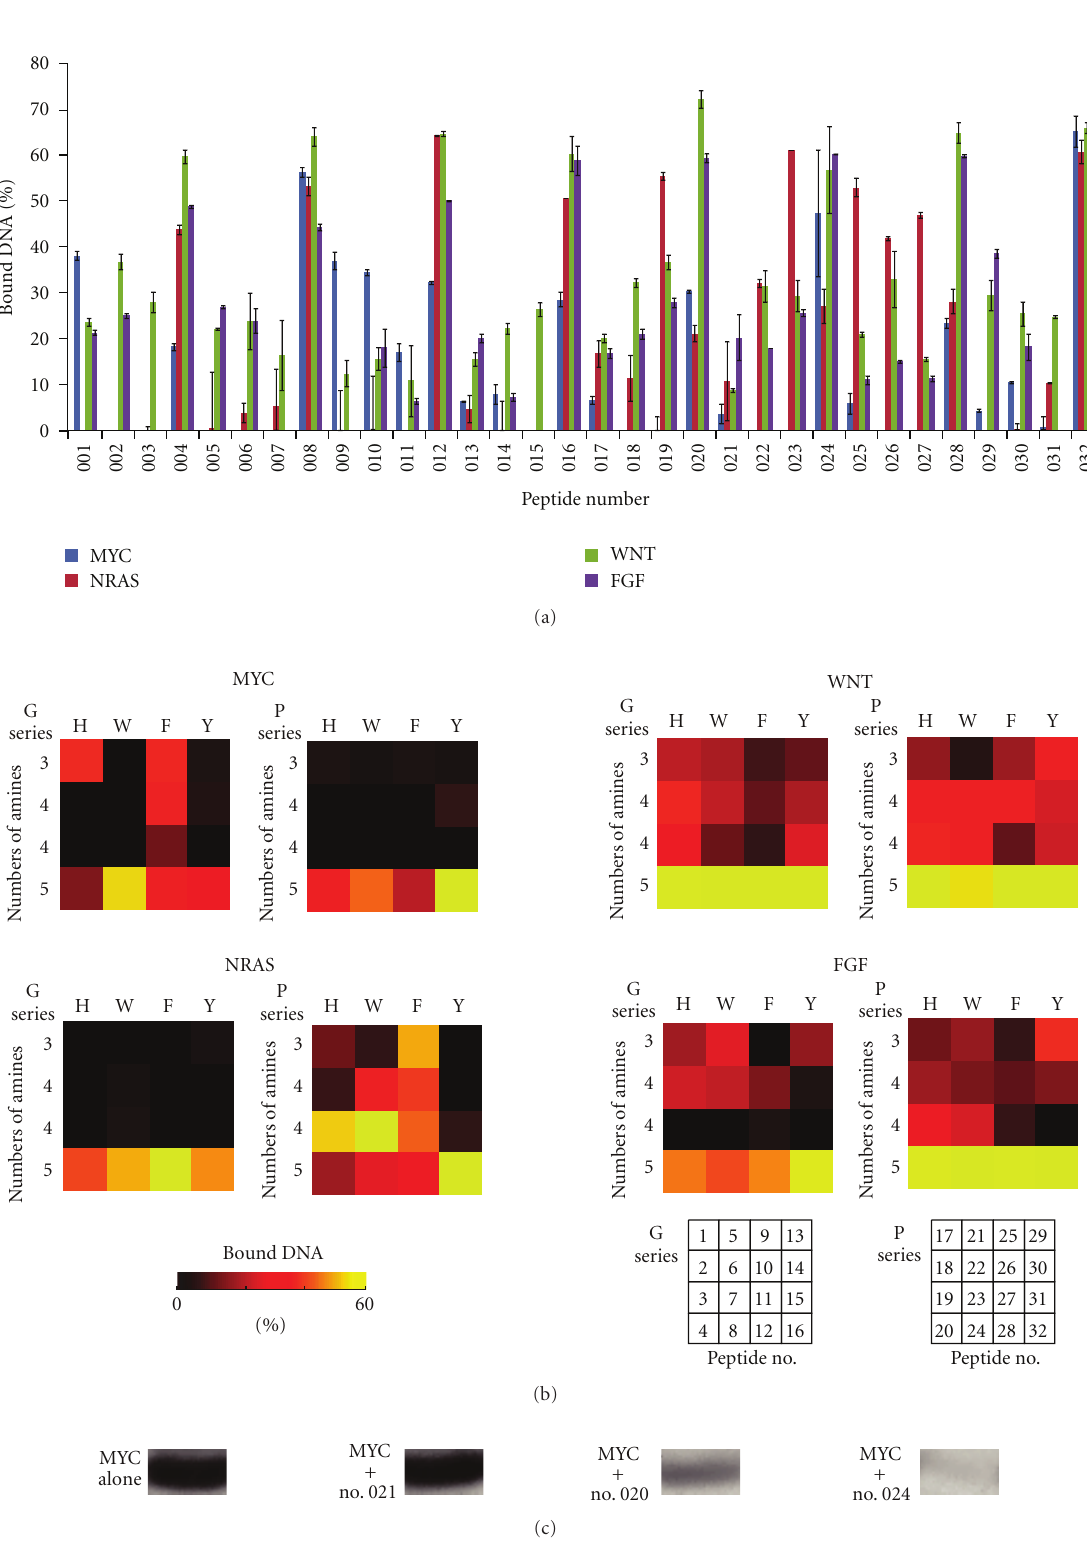
Figure 2: (a) Bound DNA percentages to each library peptide. (b) Bound DNA percentages to each peptide shown as a color illustration. (c) Typical MYC bands in PAGE. MYC alone (A representative of 0% bound DNA percentage), MYC with no. 021 (a representative of 0–10% bound DNA percentage), MYC with no. 020 (a representative of 30–40% bound DNA percentage), and MYC with no. 024 (a representative of 50–70% bound DNA